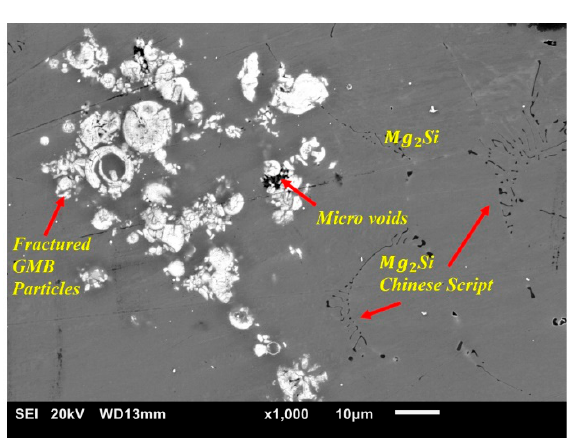
Figure 5. SEM image of Mg-20GMB core material under higher magnification.